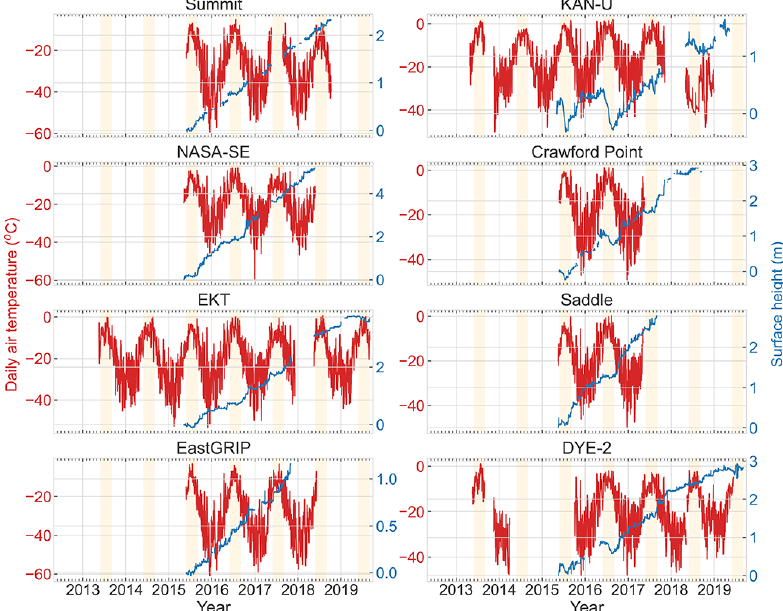
Figure 6. Daily air temperature (red line, left axis) and surface height (blue line, right axis). June–July–August are highlighted in orange. Note the different y